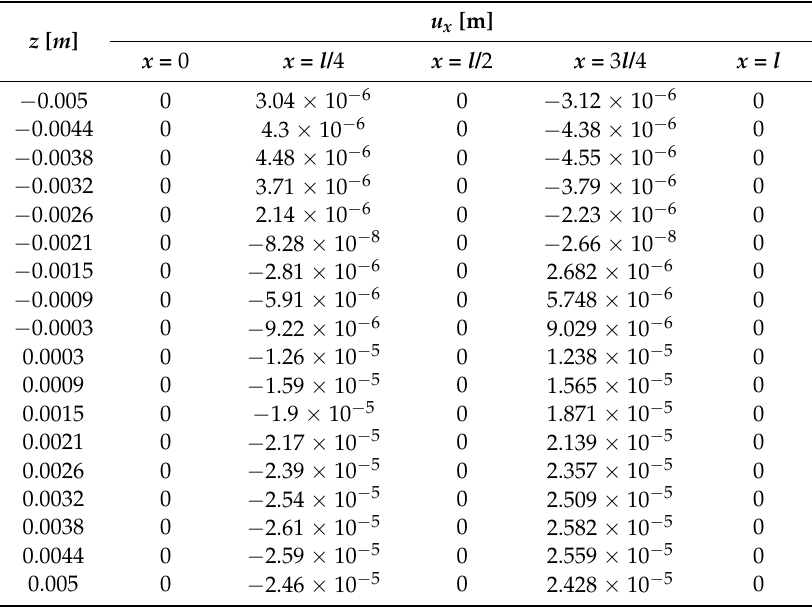
Figure 6. Longitudinal distribution of the axial ( a ) and radial ( b ) displacement components [m], in the middle and external surfaces.